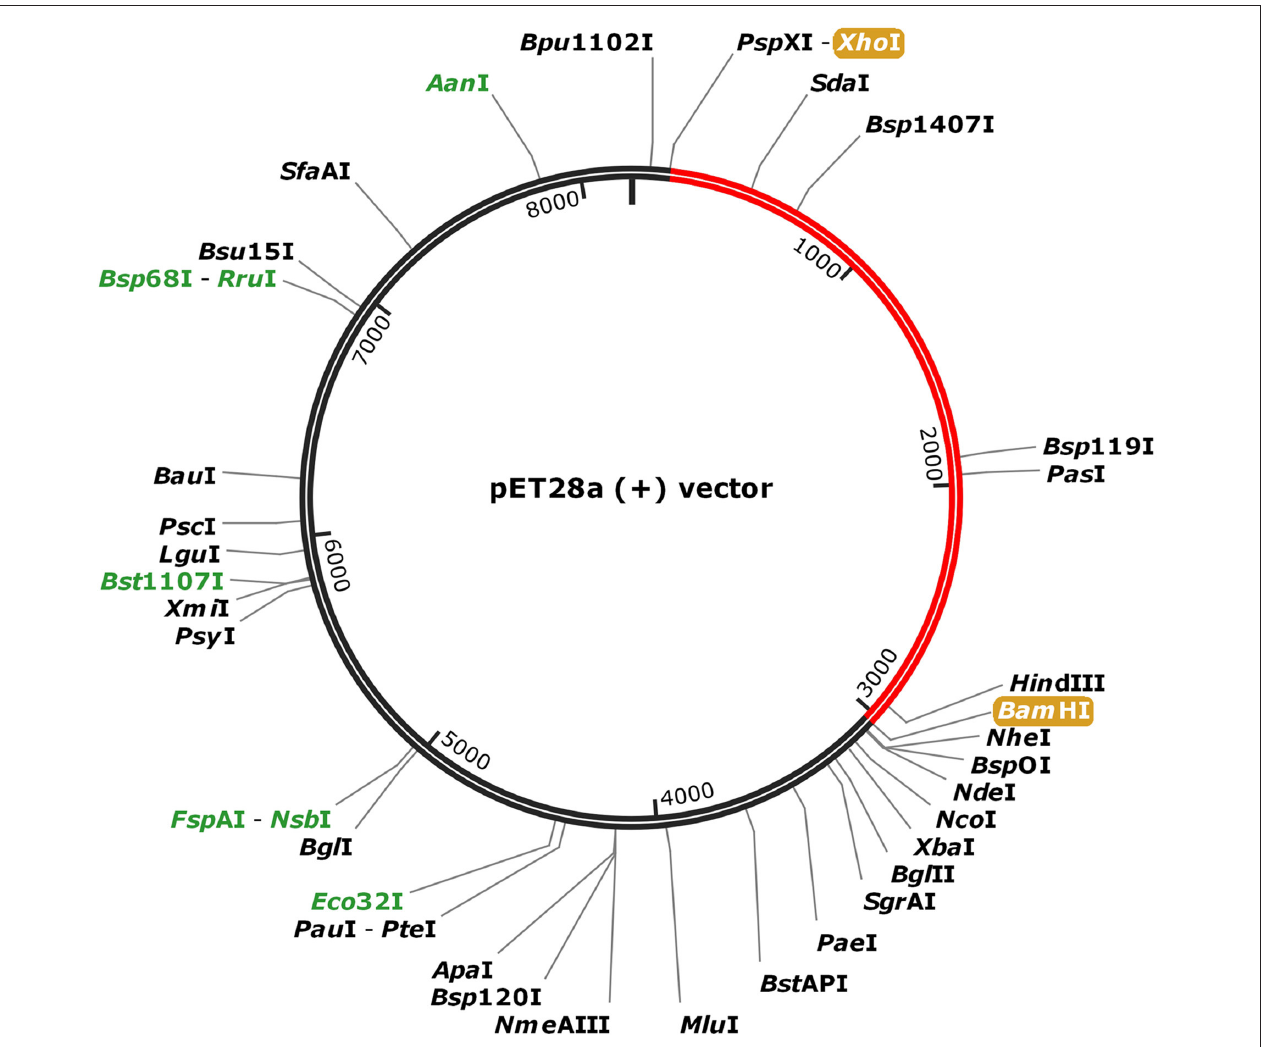
FIGURE 8 | In silico cloning of the SARS-CoV-2 vaccine in the vector, pET28a ( + ). Red areas represent the COVID-19 vaccine, while the black areas represent the expression vector, pET28a ( + ).